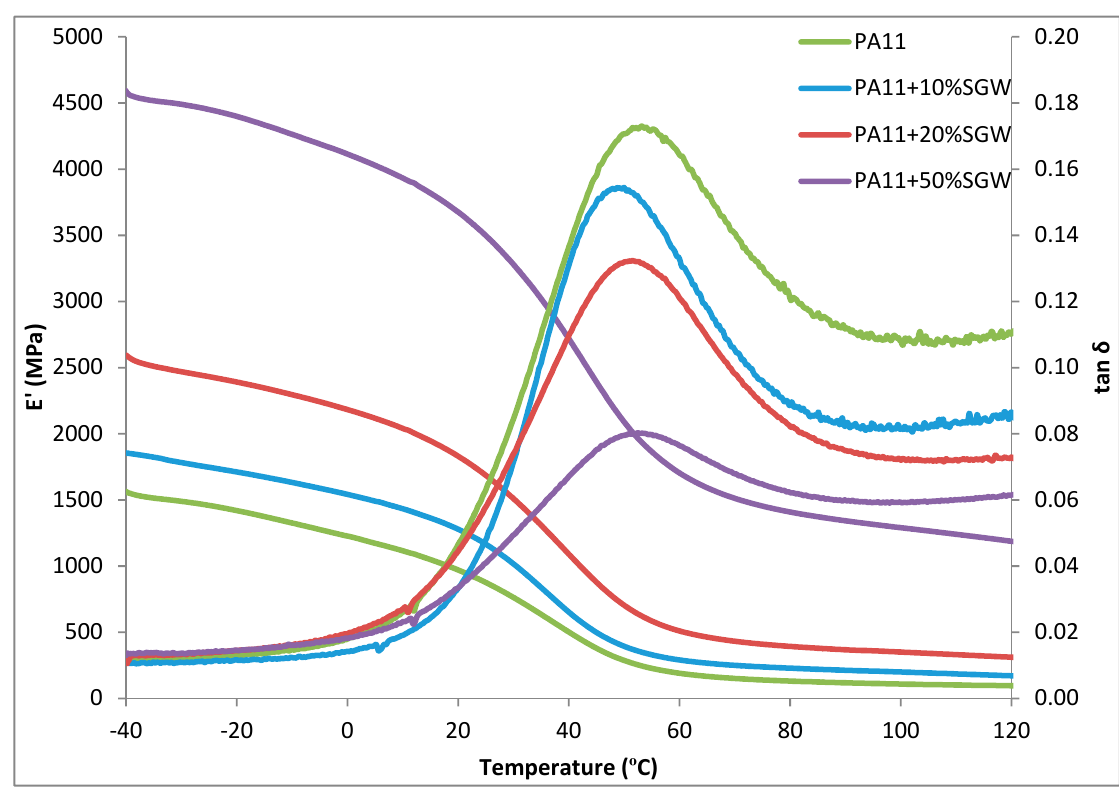
Figure 4. Storage modulus and tan δ results of PA11, PA11 + 10% SGW, PA11 + 20% SGW and PA11 + 50% SGW.